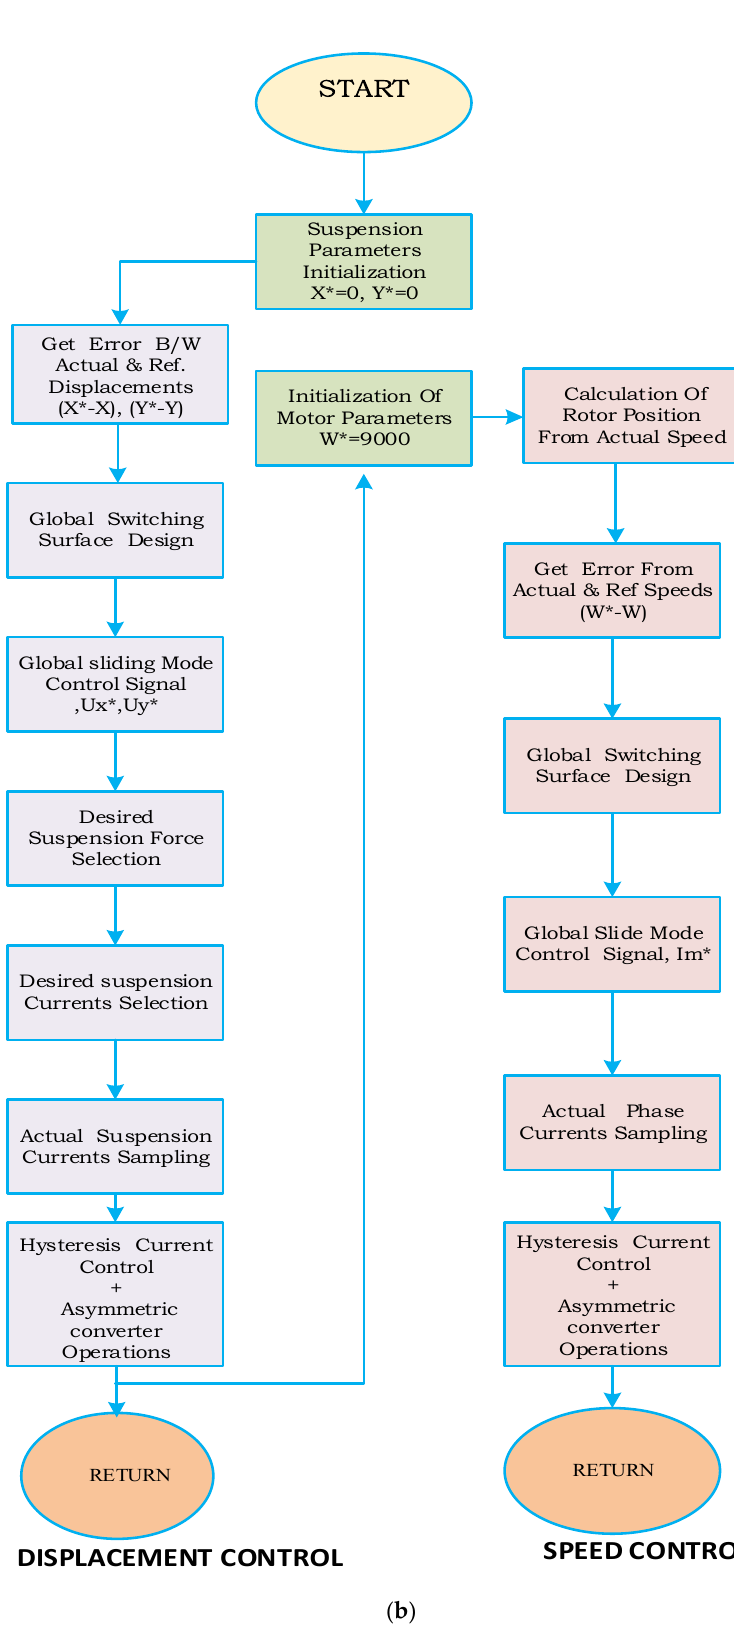
Figure 9. Design and implementation of GSMC ( a ) Block diagram representation of GSMC; ( b ) Stepwise flow chart for implementation of global sliding-mode control of BSRM.